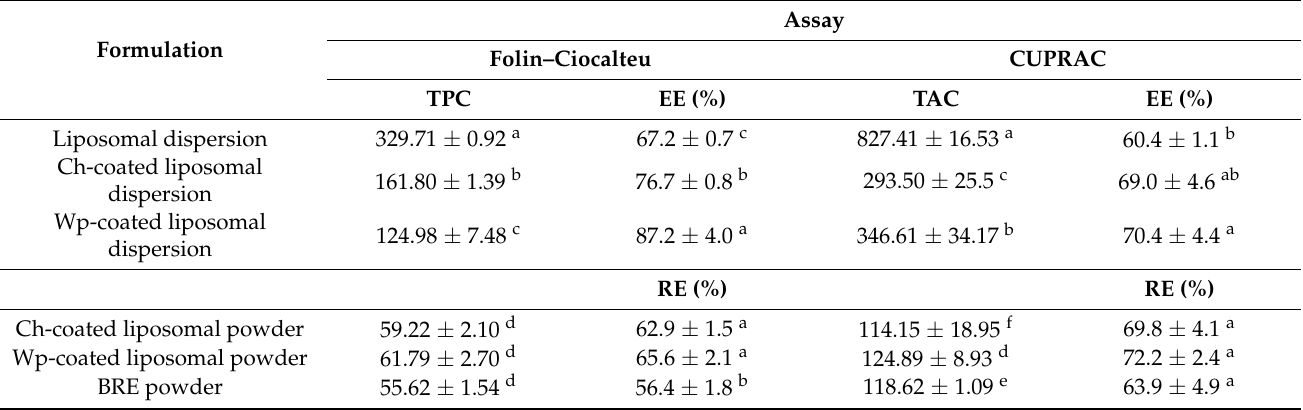
Table 6. Encapsulation efficiency (EE) and retention efficiency (RE) in terms of total (poly)phenolic content (TPC) and total antioxidant capacity (TAC) of liposomal dispersions prepared with black rosehip extract (BRE).